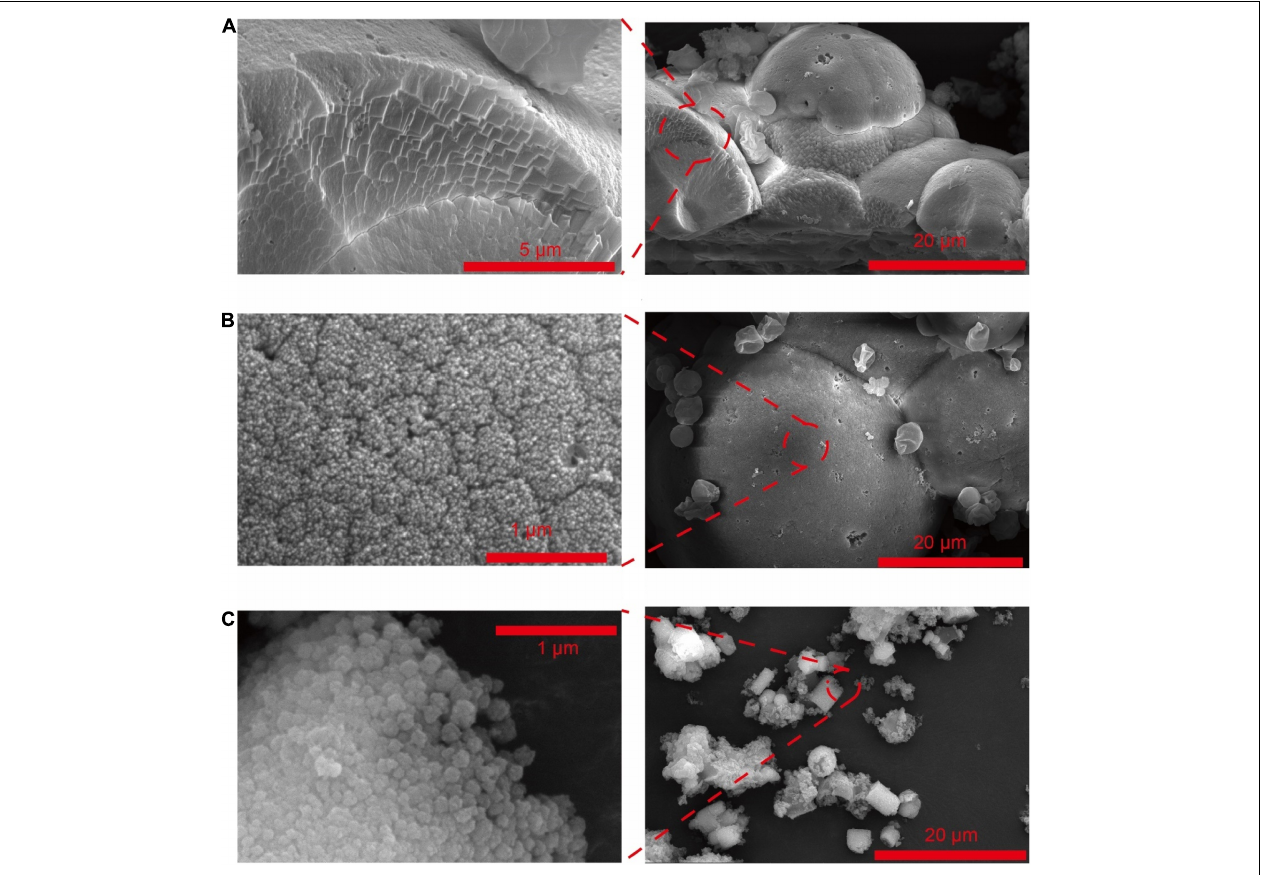
FIGURE 1 | SEM of CaCO 3 synthesized by Saccharomyces cerevisiae with different culturing conditions. (A) Acetate in B4 medium. (B) Lactate in B4 medium. (C) Acetate in B4 medium without glucose.